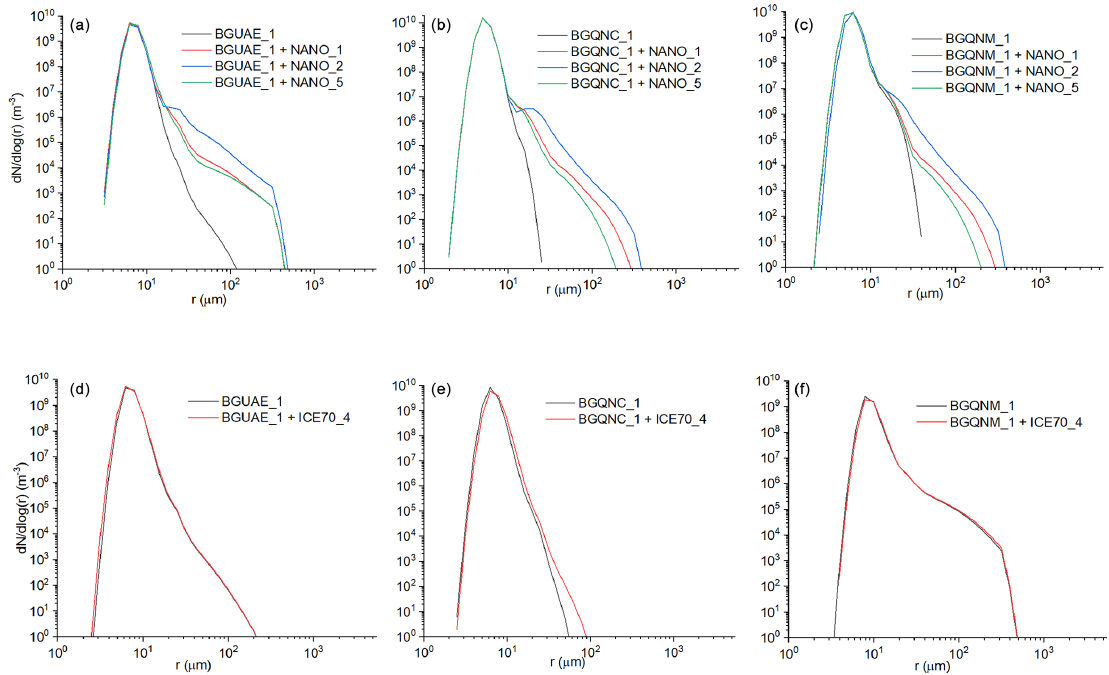
Figure 5. Impact of hygroscopic seeding at different background aerosol size distributions and in the case of different seeding materials. The black lines denote the DSD for the control cases 1km above the cloud base. The color lines denote the DSD formed due to the different seeding materials. The impact of the seeding of the nanoparticles ( a, b and c ) is presented when the updraft profile w 1 was used. In the case of ICE70 seeding material, the DSDs are calculated at updraft profile w 3